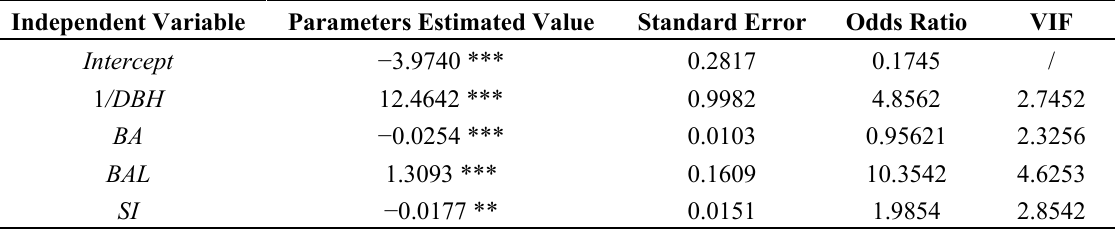
Table 4. The statistical analysis results for first-stage equations of individual tree mortality model ( n =